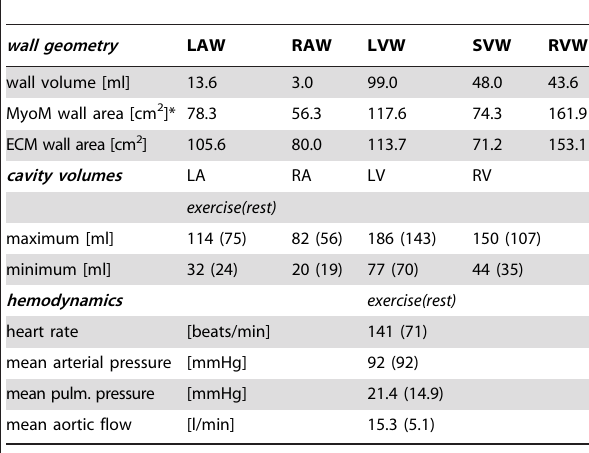
Table 1. Myocardial wall geometry and